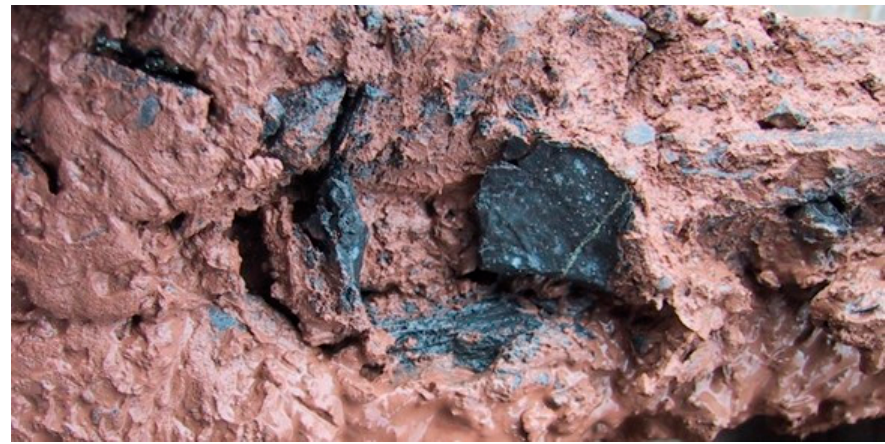
Figure 9. Example of “just-filled” commingled tailings and waste rock at Porgera Mine. Compaction refers to the process of removing large, inter-lump air voids by the